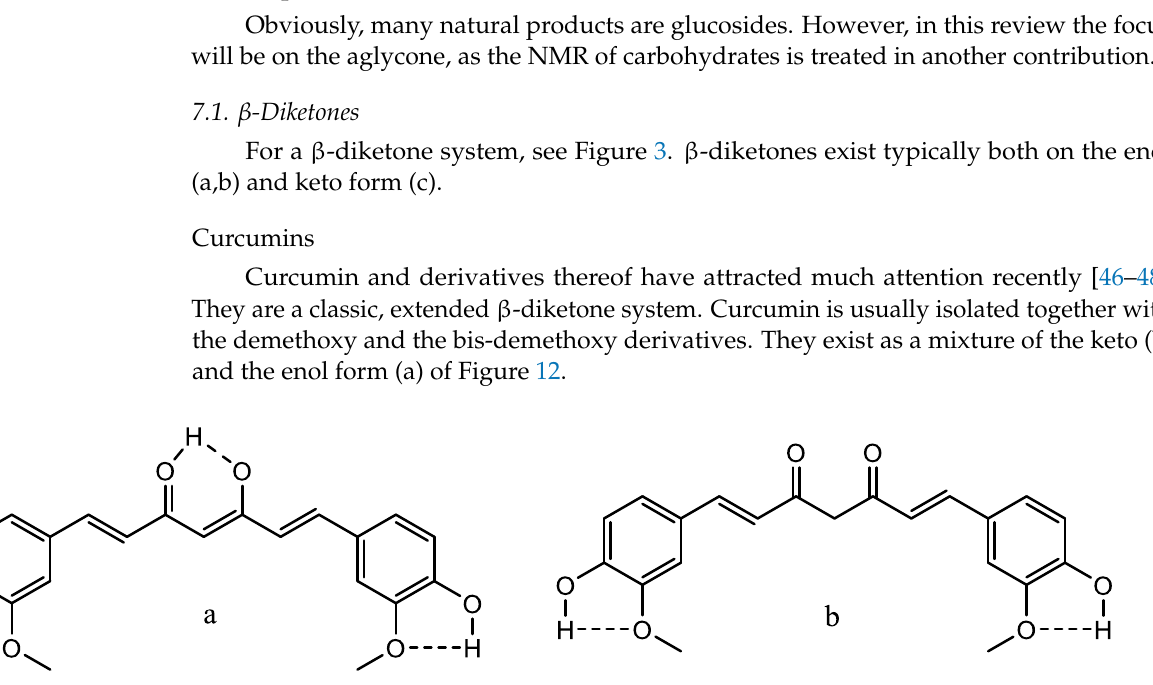
Figure 12. The two tautomers of curcumin. ( a ) is the enol-form, ( b ) the keto-form.